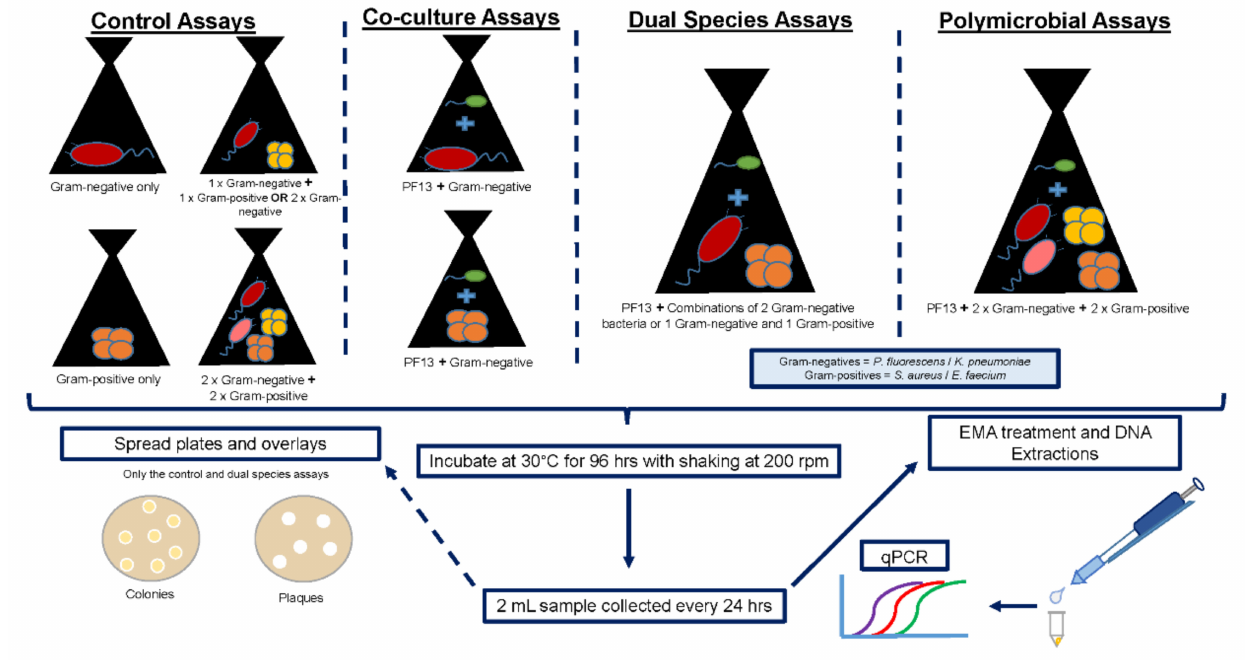
Figure 1. Summary of the control, co-culture, dual species and polymicrobial assays and the process- ing of the samples for culture- and molecular-based